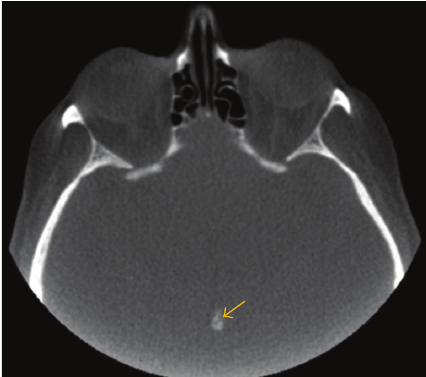
Figure 4: Axial image shows pineal gland calcification in the